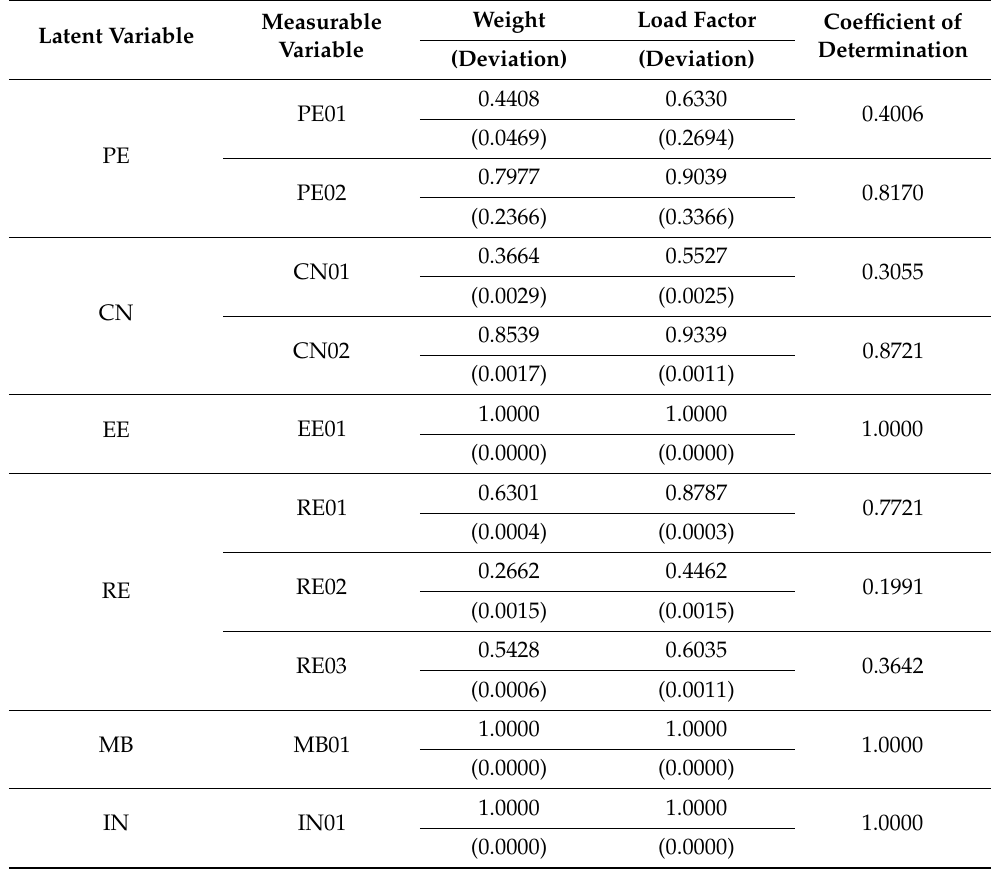
Table 3. Results of external model parameter estimations as well as deviation of estimation obtained by Tukey’s